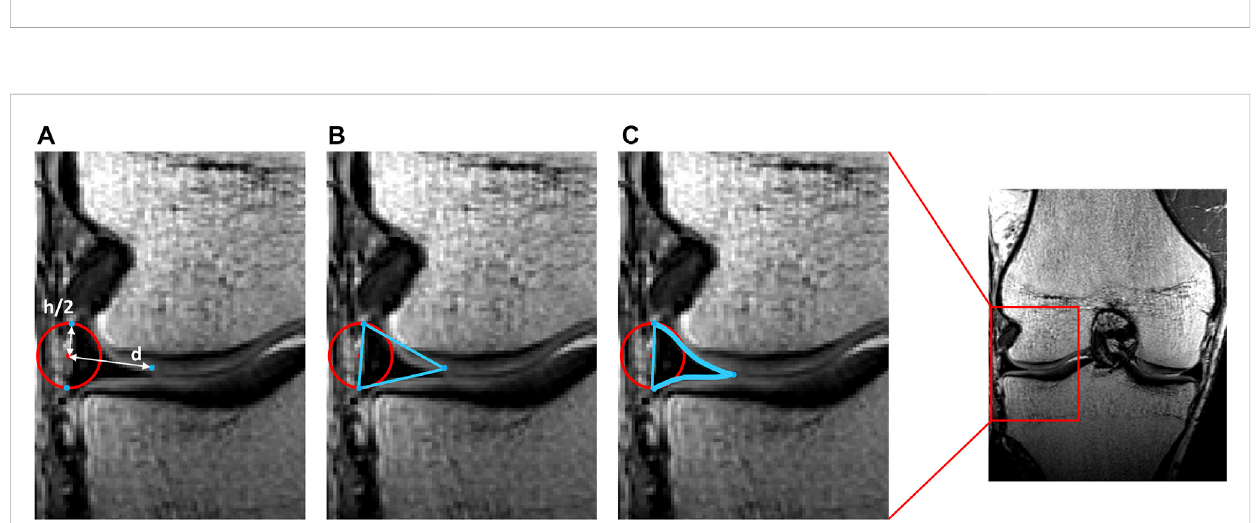
FIGURE 2 SagittalviewofthefemoralcondyleonMRI.Thenode-speci fi ccartilagethicknesswasde fi nedasthedistanceofthevertex(locatedontheblueline) to the cartilage surface (red), along the vertex normal.